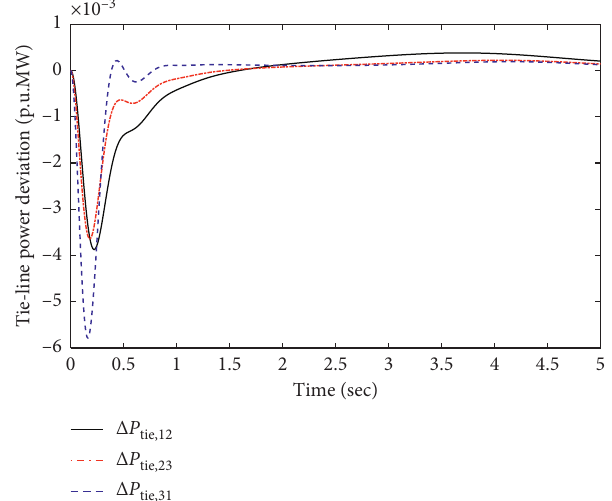
Figure 9: Tie-line deviation of the system under mismatched uncertainty.